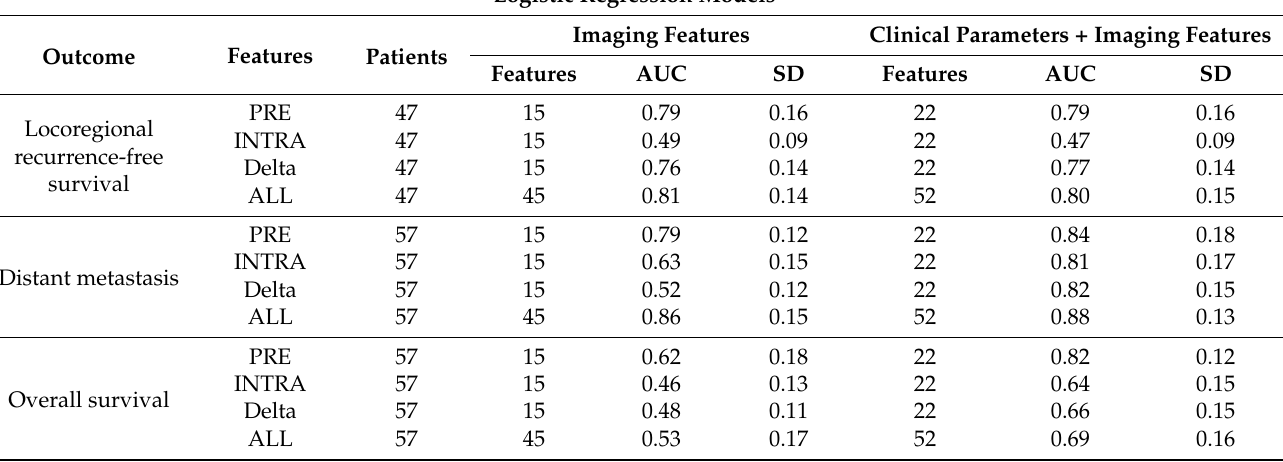
Table 2. Prognostic models (Lasso logistic regression) of the 15 imaging features (Table S4) without and with clinical features (Table S2), predicting locoregional recurrence-free survival, distant me- tastasis-free survival and overall survival, with the amount of patients (Table S7). The amount of features and the area under the curve (AUC) with the standard deviation (SD) is tabulated.